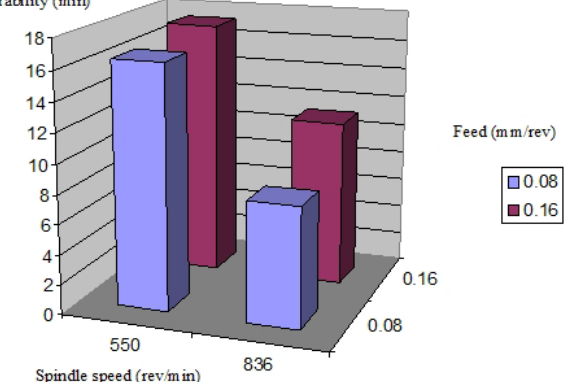
Figure 25. Graphical representation of the durability.